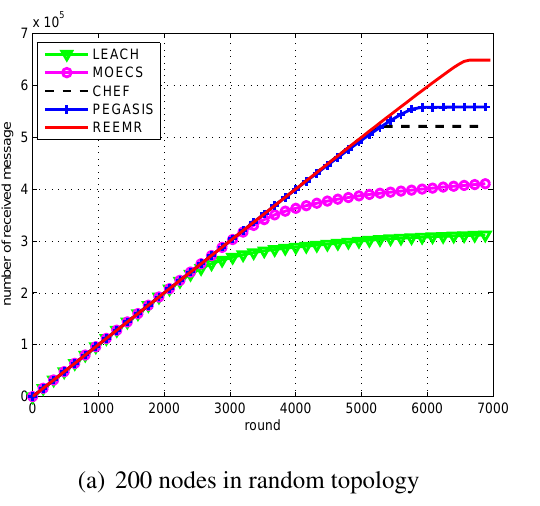
Figure 14. Total number of data messages received at the base